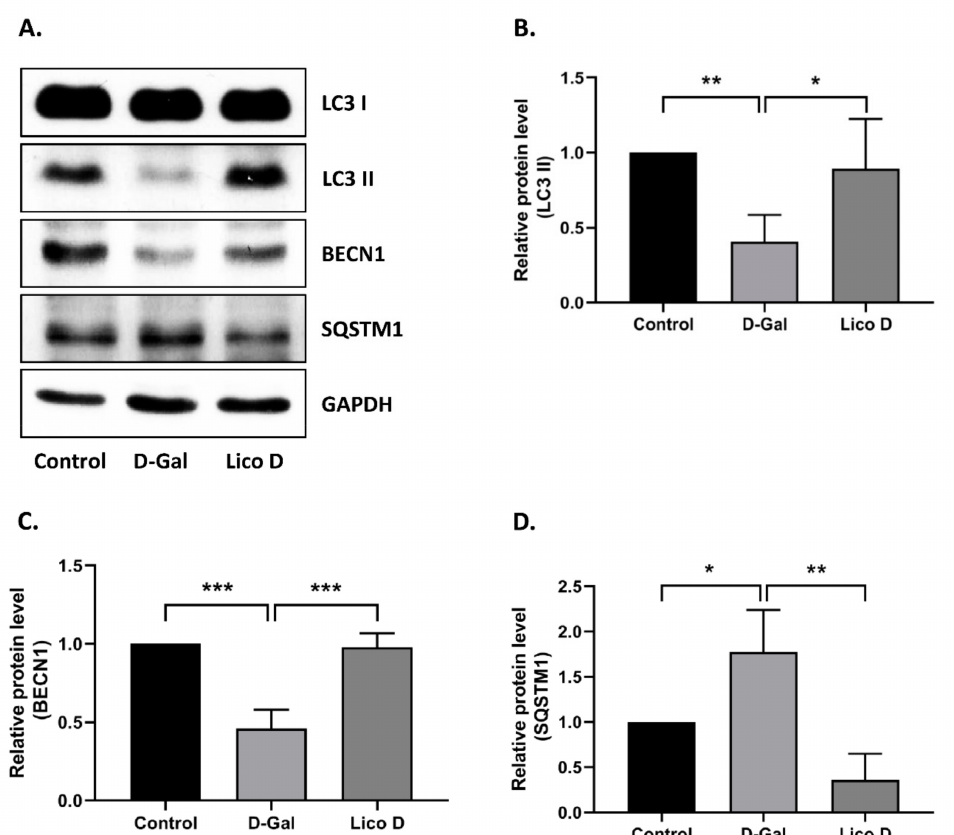
Figure 7. AMPK activation improved autophagy in D-Gal induced aging mice heart tissue. Representative images from immunoblot against LC3 II, BECN1, SQSTM1 and GAPDH from heart ( A – D ) tissue. The expression levels of proteins were quantified using Images J software. All data are represented as mean ± SD ( n = 3). * p < 0.05, ** p < 0.01, and *** p <